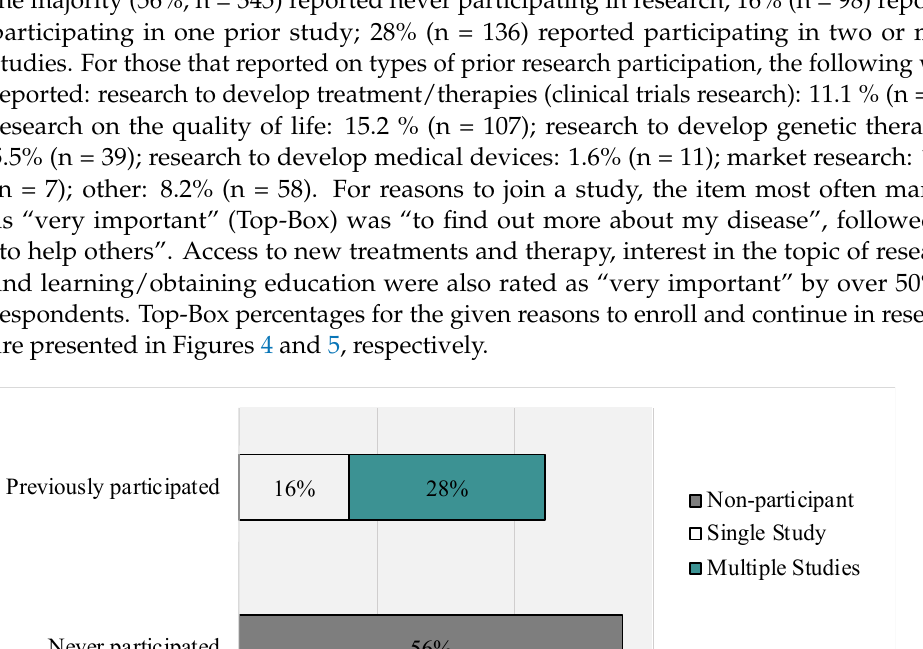
Figure 4. Rankings of Reasons for Joining a Research Study. Top Box Responses (“very important”) are Presented. Figure 5. Rankings of Reasons for Staying Enrolled in a Research Study. Top Box Responses (“Very Important”) are Presented. When participants were asked to report on reasons why they would withdrawal from a study, ‘Risks of treatment’ and ‘Study side effects’ were the most common responses with items receiving 49% and 48% of top ‐ box responses, respectively. Top ‐ Box percent ‐ ages for reasons to withdraw are presented in Figure 6. Of note, the overall percentage of participants selecting the top ‐ box (“very important”) response was low across study with ‐ drawal items.